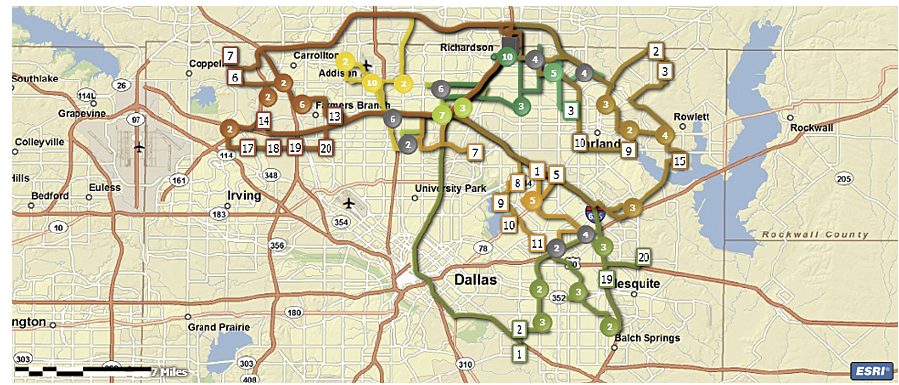
Figure 6. An example of network analysis related to finding closest facilities (adapted from [31]).